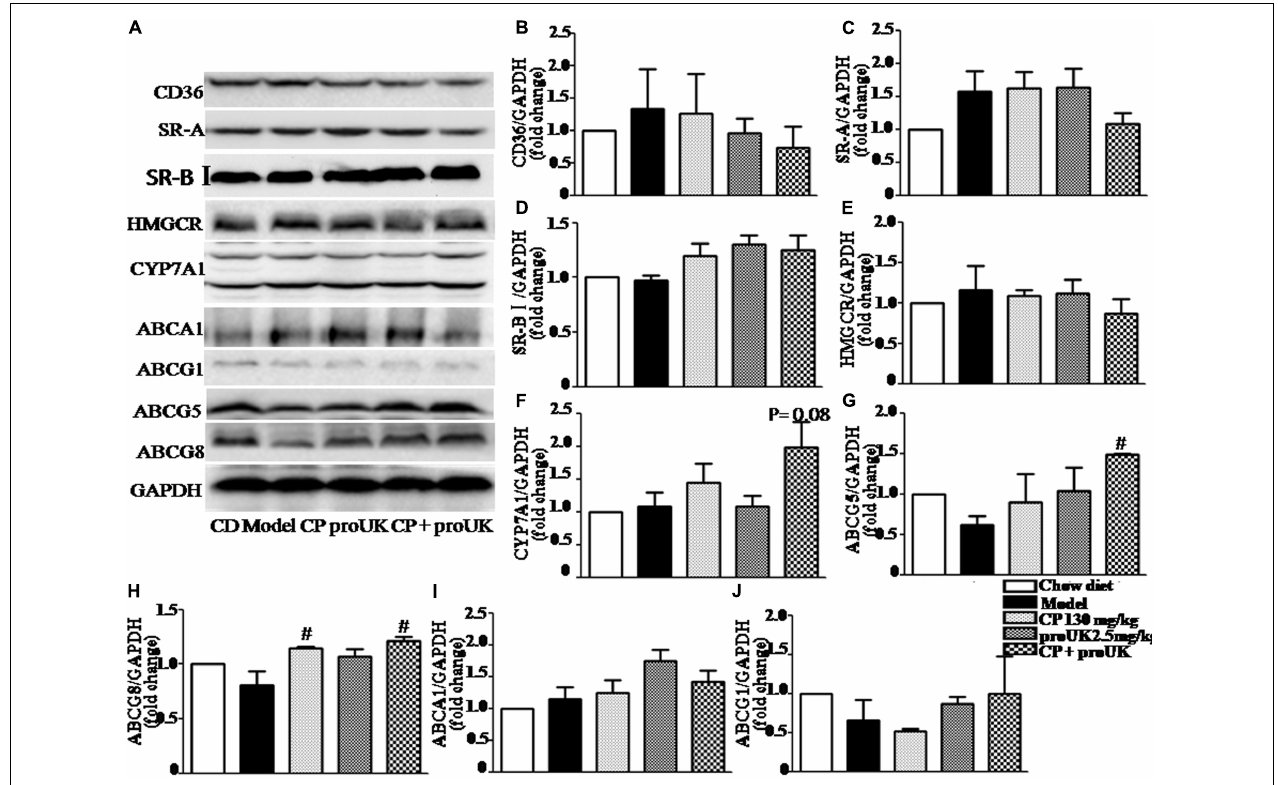
FIGURE 5 | Effect of CP plus proUK on the proteins associated with lipid metabolism in the livers of LDLR − / − mice. (A) Western blotting of CD36, SR-A, SR-BI, ABCA1, ABCG1, ABCG5, ABCG8, HMGCR, and CYP7A1 in the livers of LDLR − / − mice from different groups. (B–D) The quantitative analysis of the expression of scavenger receptor CD36, SR-A, SR-BI in the liver from different groups. (E) The quantitative analysis of the expression of cholesterol synthesis rate-limiting enzyme HMGCR in the liver from different groups. (F) The quantitative analysis of CYP7A1 expression in the liver from different groups. (G) The quantitation of the ratio betweenABCG5 protein/GAPDH protein in the liver from different groups. (H) The quantitation of the ratio betweenABCG8 protein/GAPDH protein in the liver from different groups. (I) The quantitative analysis of ABCA1 expression in the liver from different groups. (J) The quantitative analysis of ABCG1 expression in the liver from different groups. n = 5. # P < 0.05 vs. Model